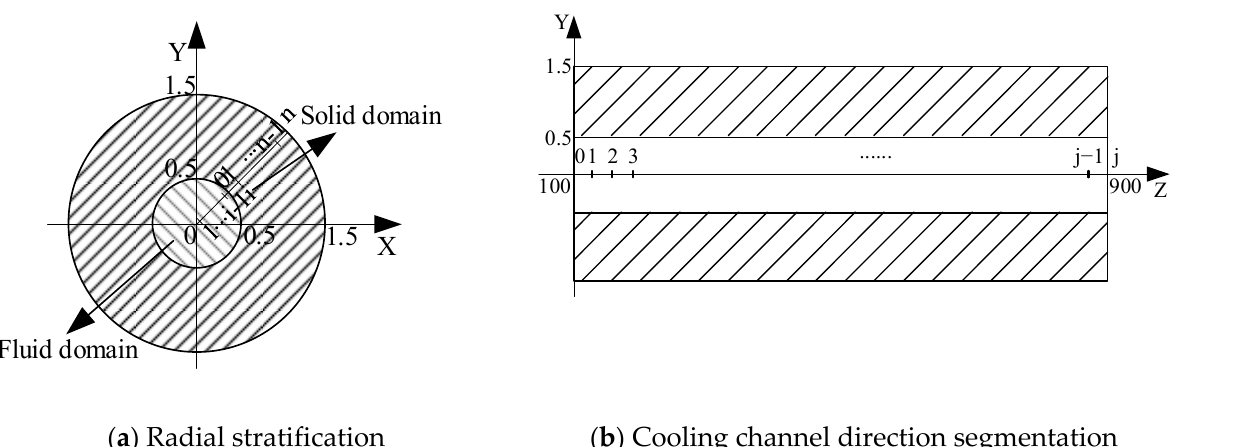
Figure 1. Schematic diagram of the cooling channel division structure.